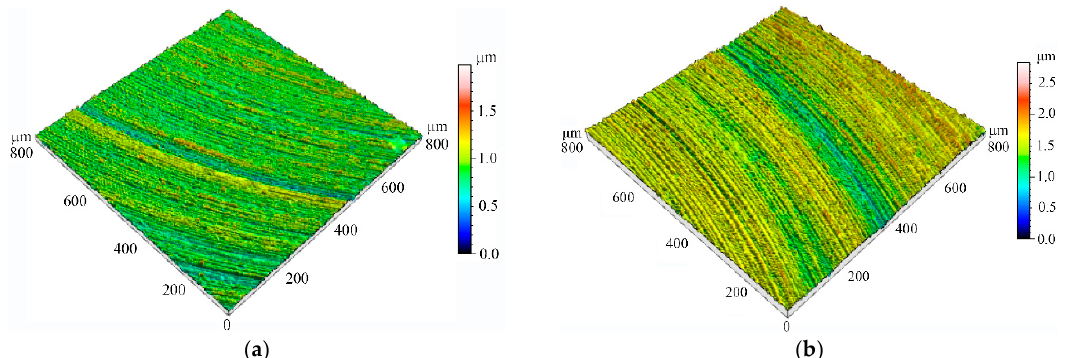
Figure 8. Selected machined surface local detail topography. ( a ) Test No. 1; ( b ) Test No. 3.